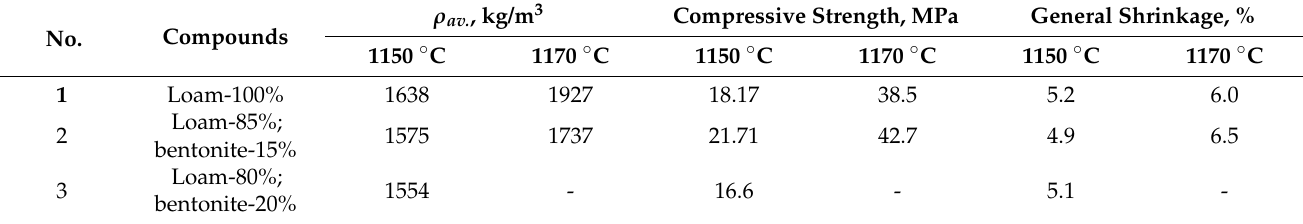
Table 5. The compounds and properties of samples with